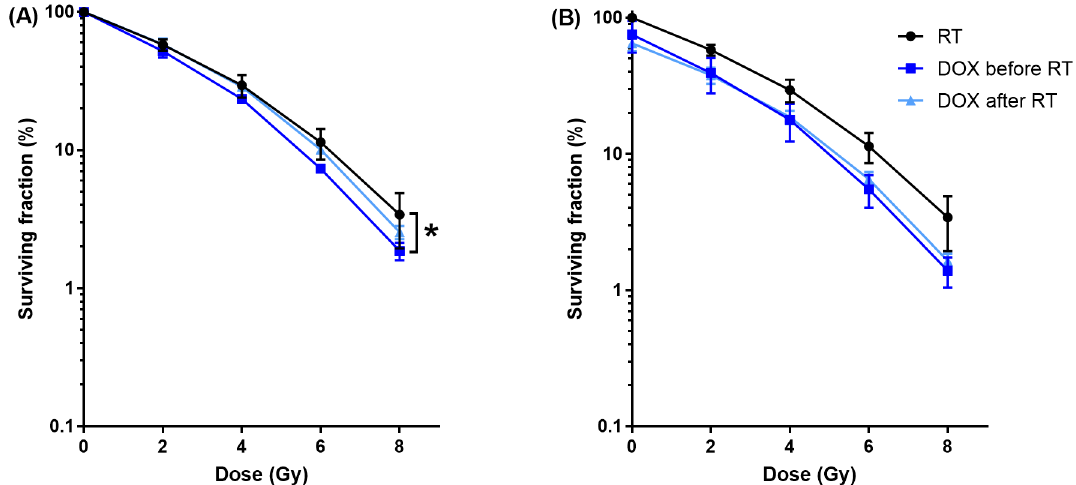
Fig 4. Cytotoxicity of DOX before or after RT. Surviving fraction as function of radiation dose. Cells were exposed for 1 hour to DOX (0.02 μ g/mL) before or after RT, normalized for DOX at 0 Gy (A) and normalized for untreated samples (0 μ g/ml and 0 Gy) (B). Only DOX before RT resulted in a significant enhancement of the RT.